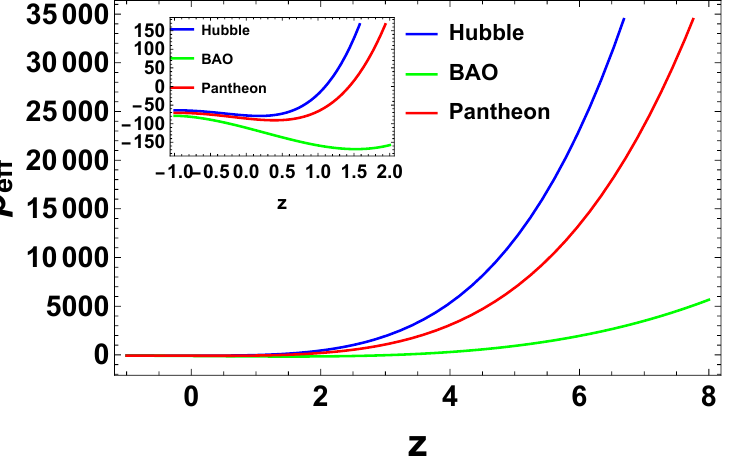
Figure 7. Profile of the pressure for the given model corresponding to the values of the parameters constrained by the Hubble, BAO, and Pantheon data point sets.